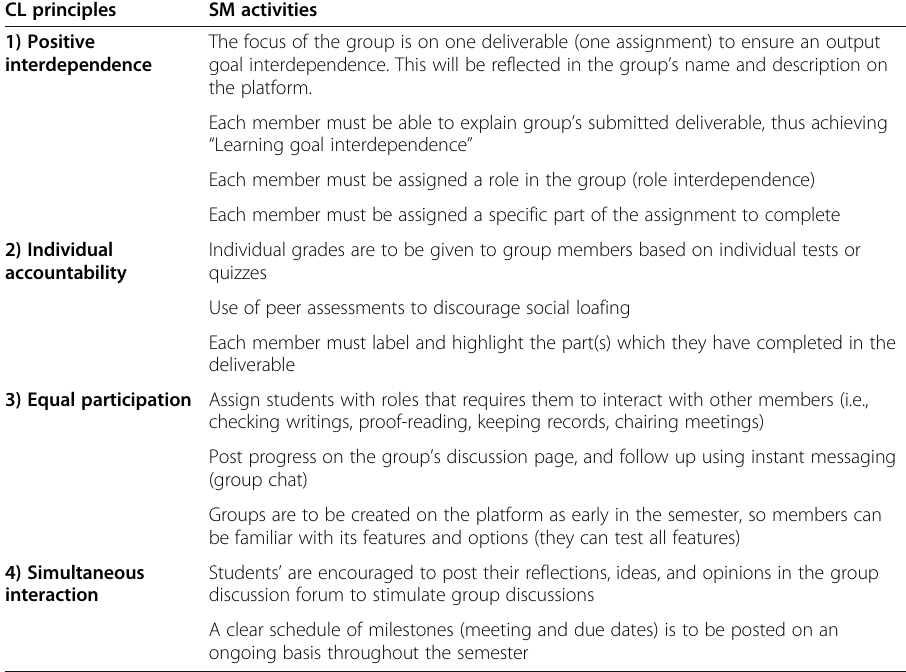
Table 5 SM activities in support of CL CL